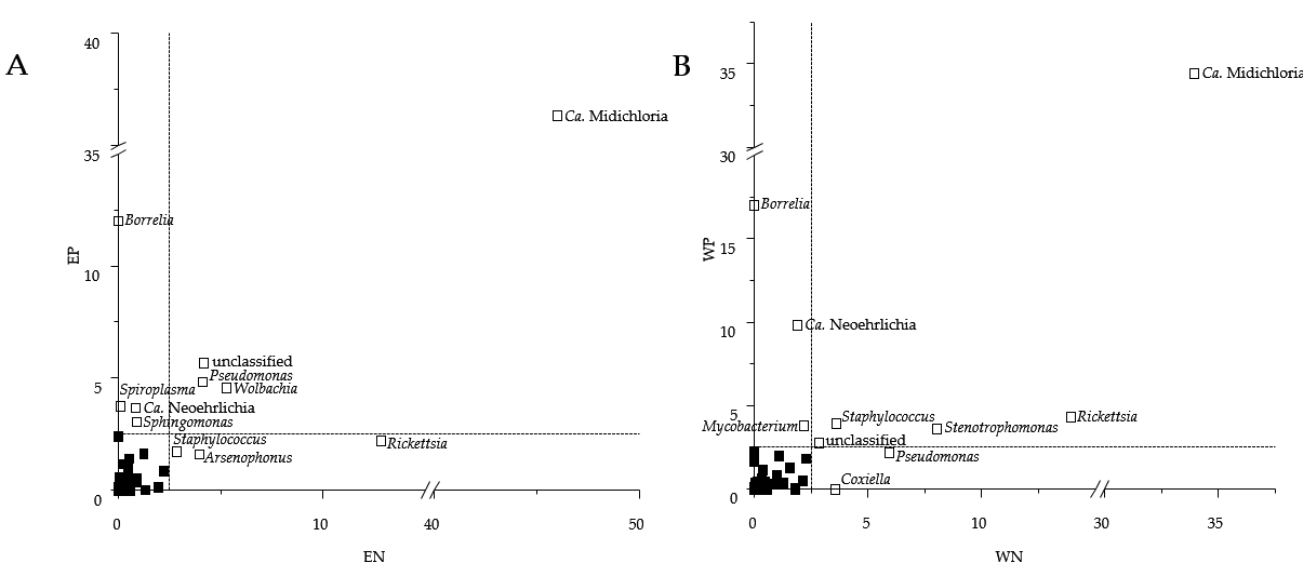
Figure 3. Differences in the sequence read abundances of bacterial genera obtained from tick-borne bacterial community compositions from Esslingen ( A ) (EN, Borrelia -negative, n = 62; EP, Borrelia -positive, n = 38) and Weiden ( B ) (WN, Borrelia - negative, n = 56; WP, Borrelia -positive; n = 44). Only bacterial genera were shown with a mean relative abundance of at least 2.5% in Esslingen (E) or Weiden (W).